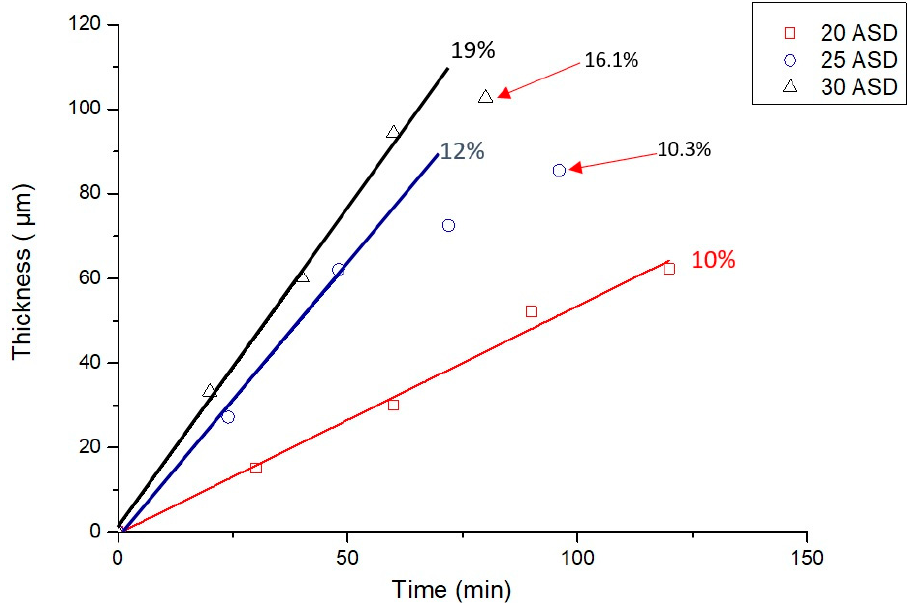
Figure 2. Current efficiencies of Cr-Fe-C alloy electrodeposition in terms of electroplating current densities and periods.